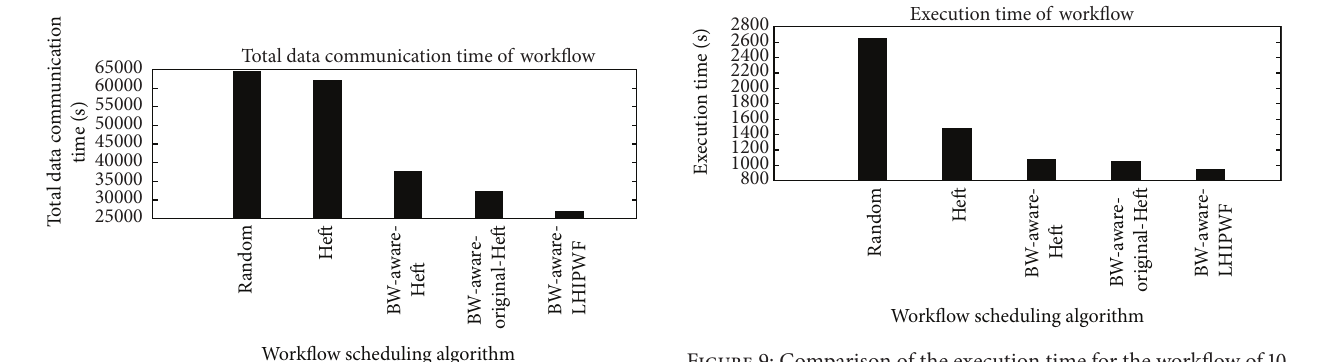
Figure 9: Comparison of the execution time for the workflow of 10 tasks.